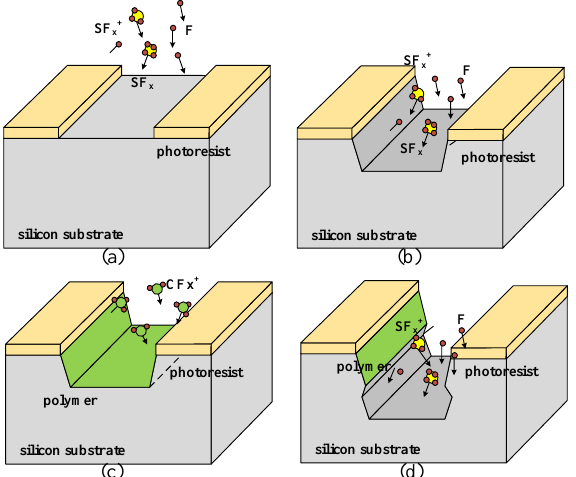
Figure 1. Schematics of the principle of the DRIE process. ( a ) The initial state. ( b ) The first etching process. ( c ) The upcoming passivation. ( d ) The second etching process.